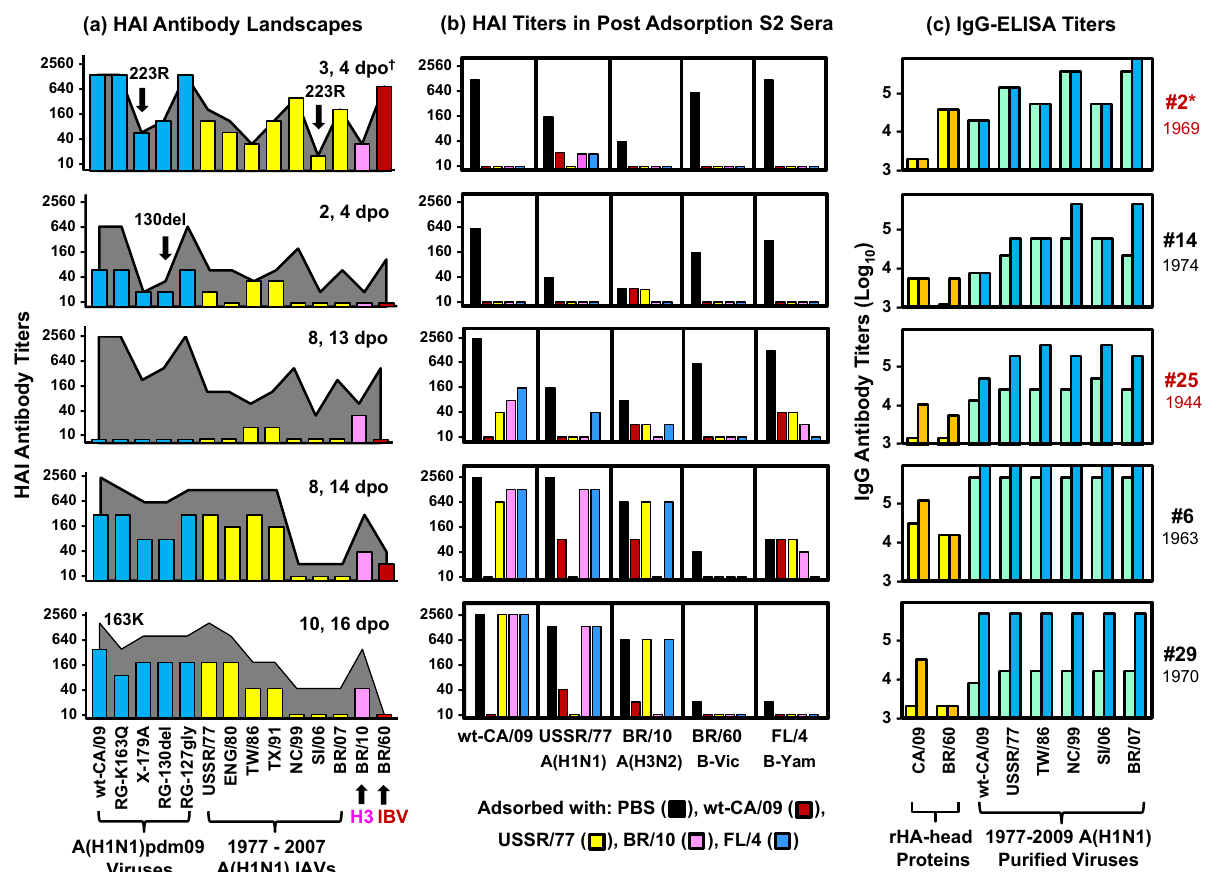
Figure 4. HAI antibodies targeting epitopes possessing HA-(K130 + Q223) cross-reacted with A(H3N2) IAV or IBVs. ( a ) HAI antibody landscapes in 5 patients were constructed using HAI assays with the 14 indicated viruses. HAI titers in S1 were shown in different colored bars: blue bars for wt-CA/09 and CA/09-mutants, yellow bars for 1977–2007 A(H1N1), pink bars for BR/10 A(H3N2), and red bars for BR/60 IBV. HAI antibody titers in the second sera are shown in gray landscapes. ( b ) Sera were adsorbed with purified viruses or PBS as a control. Post adsorption sera were tested by HAI assays with wt-CA/09, USSR/77, BR/10, BR/60 and FL/4. Antibody titers are expressed as color bars: post-adsorbed with PBS in black, wt-CA/09 in red, USSR/77 in yellow, BR/10 in pink, and FL/4 in blue. We completed two independent antibody adsorption assays. ( c ) Paired sera were tested by IgG-ELISA using two rHA-heads from CA/09 or BR/60 and 6 purified A(H1N1) viruses. IgG titers are shown in yellow or light blue bars for S1 and orange or dark blue bars for the second sera. We completed two independent ELISA assays. *Patient number (fatal patients in red) with birth year. † Serum collection days post-symptom onset